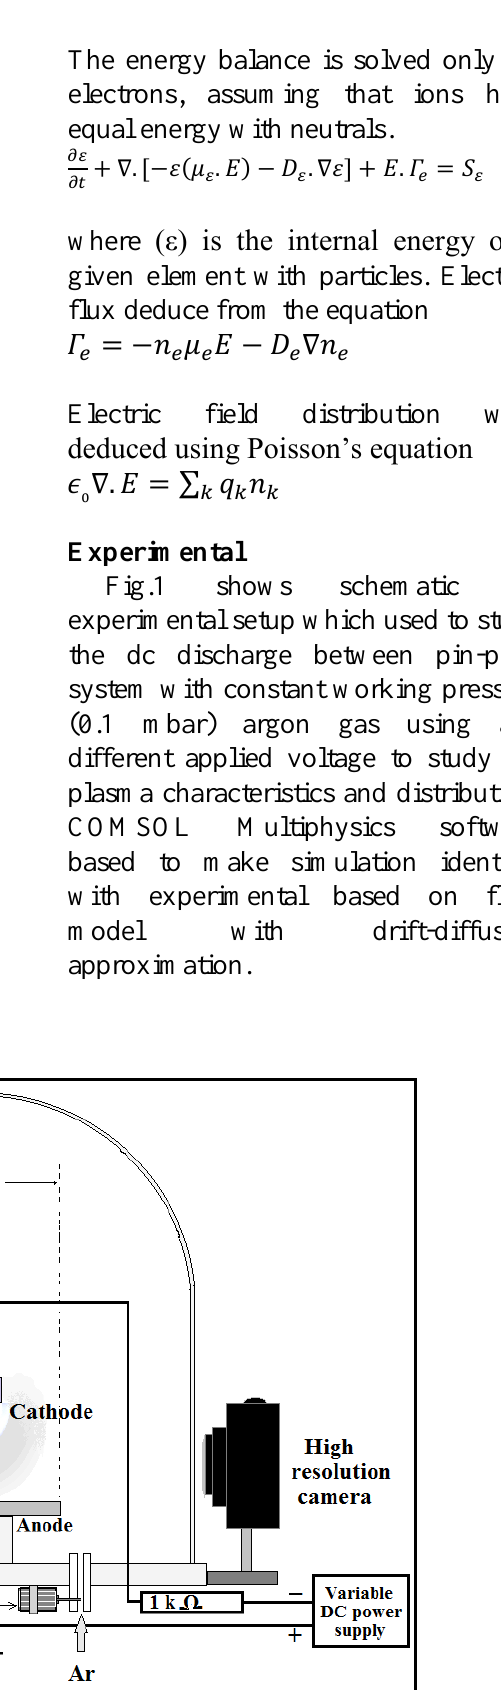
Fig. 1: Schematic for experimental